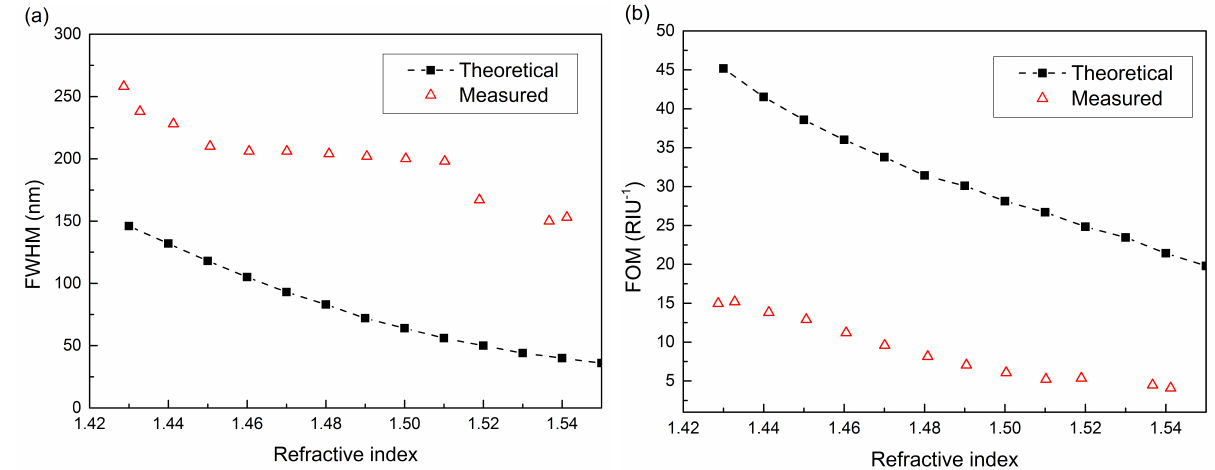
Figure 6. Comparison of measured transmission spectra and theoretical results with different n . ( a ) FWHM versus n ; ( b ) figure of merit (FOM) versus n s s